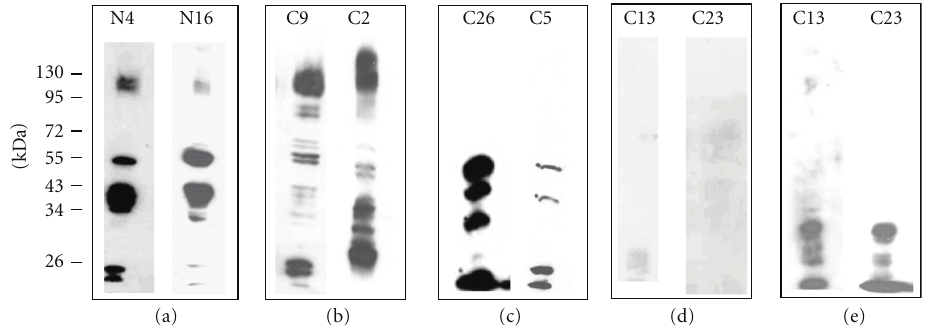
Figure 1: The profile of band 3 in the membranes of normal and CML erythrocytes. Western-blotted membrane proteins of erythrocytes (a–d) were stained with monoclonal anti-band 3 antibody. (a) The normal erythrocyte (N) shows the parent band 3 molecule at 95kDa, and fragments at 55, 43, and below 26kDa. (b–e) CML samples designated as “C” showed varied degree of fragmentation of band 3 as shown in (b) wherein parent band 3 is seen at 95 kDa and all fragments observed in normal are additionally cleaved (c) in which parent band 3 is not detected, and fragments detected in normal erythrocyte show greater intensity compared to the normal sample (d) where neither parent molecule nor the fragments are detected; (e) the fragments not detected in the representative CML sample in (d) are stained by polyclonal antibody to the whole band 3 molecule, thus indicating excessive cleavage of the N-terminal region which is detected by the monoclonal